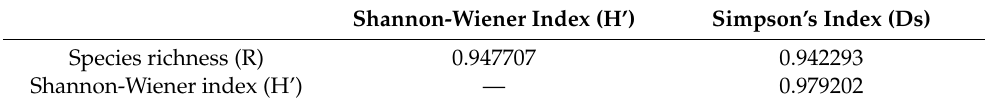
Table 2. Pearson’s correlation coefficient between the three diversity indices used in the current study.